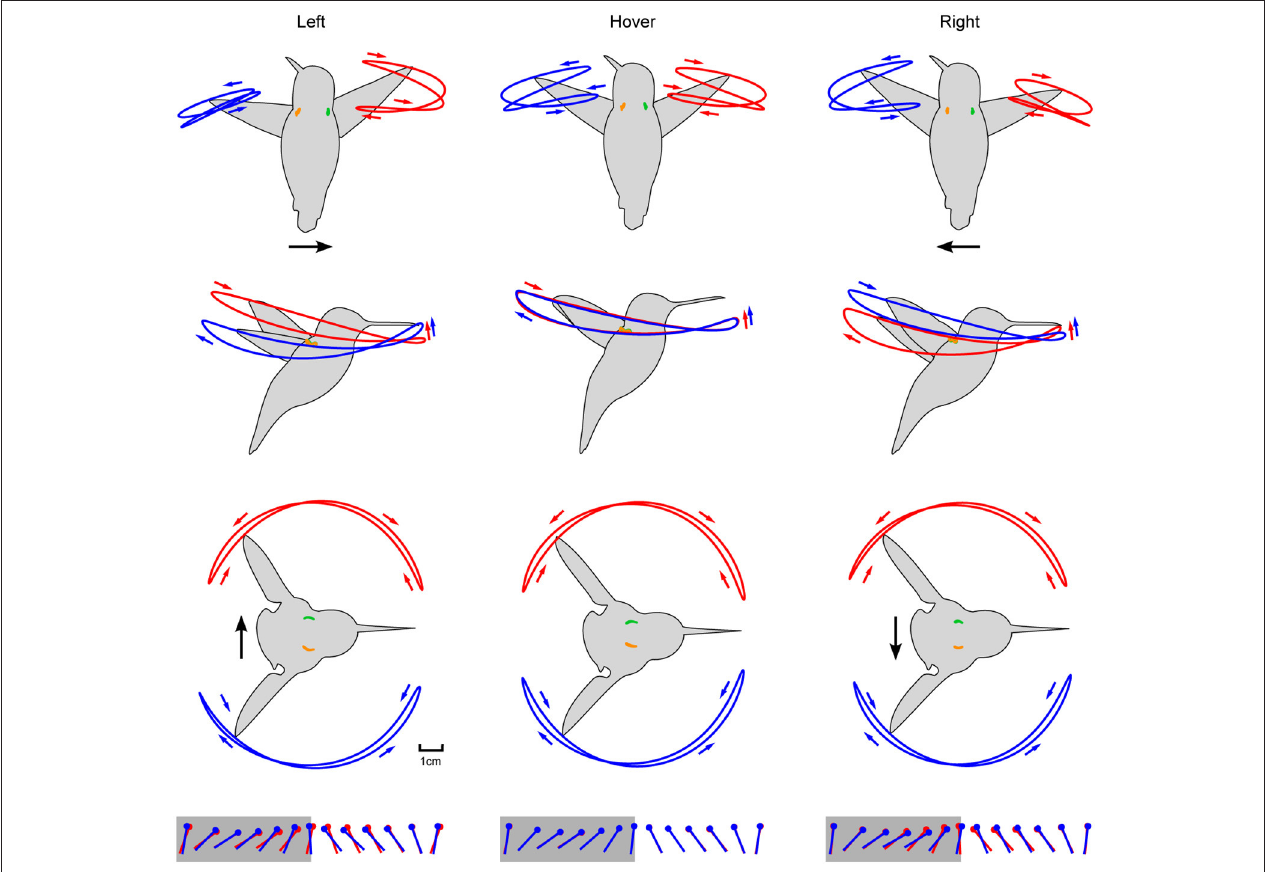
FIGURE 5 | Aligning the wing and body kinematics reveals that hummingbirds are steering against the motion of the laterally moving feeder. Feeder tracking to the left is shown in the left column with rows 1–3 depicting the front, side, and top views, respectively. These same perspectives for hovering and feeder tracking to the right are given in the middle and right columns, respectively. Black arrows represent direction of flight and anatomical features are color coded as in Figure 4B . Stroke direction is indicated by small blue and red arrows. The fourth row depicts the kinematic angle of attack during the downstroke (gray) and upstroke